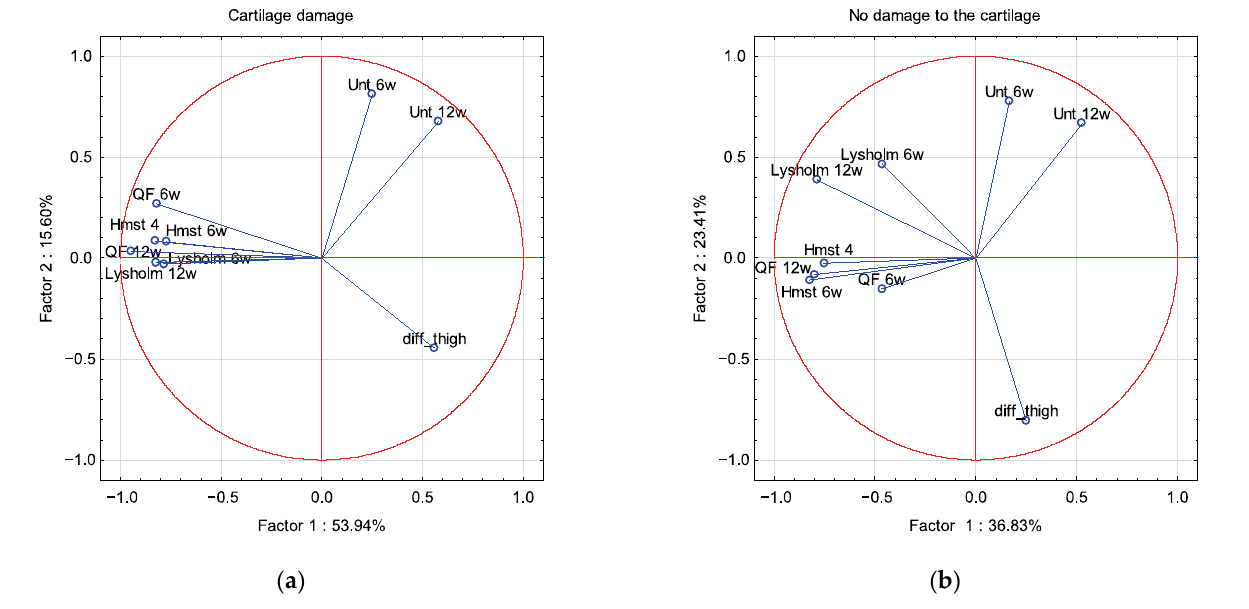
Figure 5. A graphic illustration of Principal Components Analysis of Lysholm, Unterberger test and muscle strength. Projection of the variables on the factor plane of the first two principal components for damage ( a ) and no damage ( b ) to the cartilage.